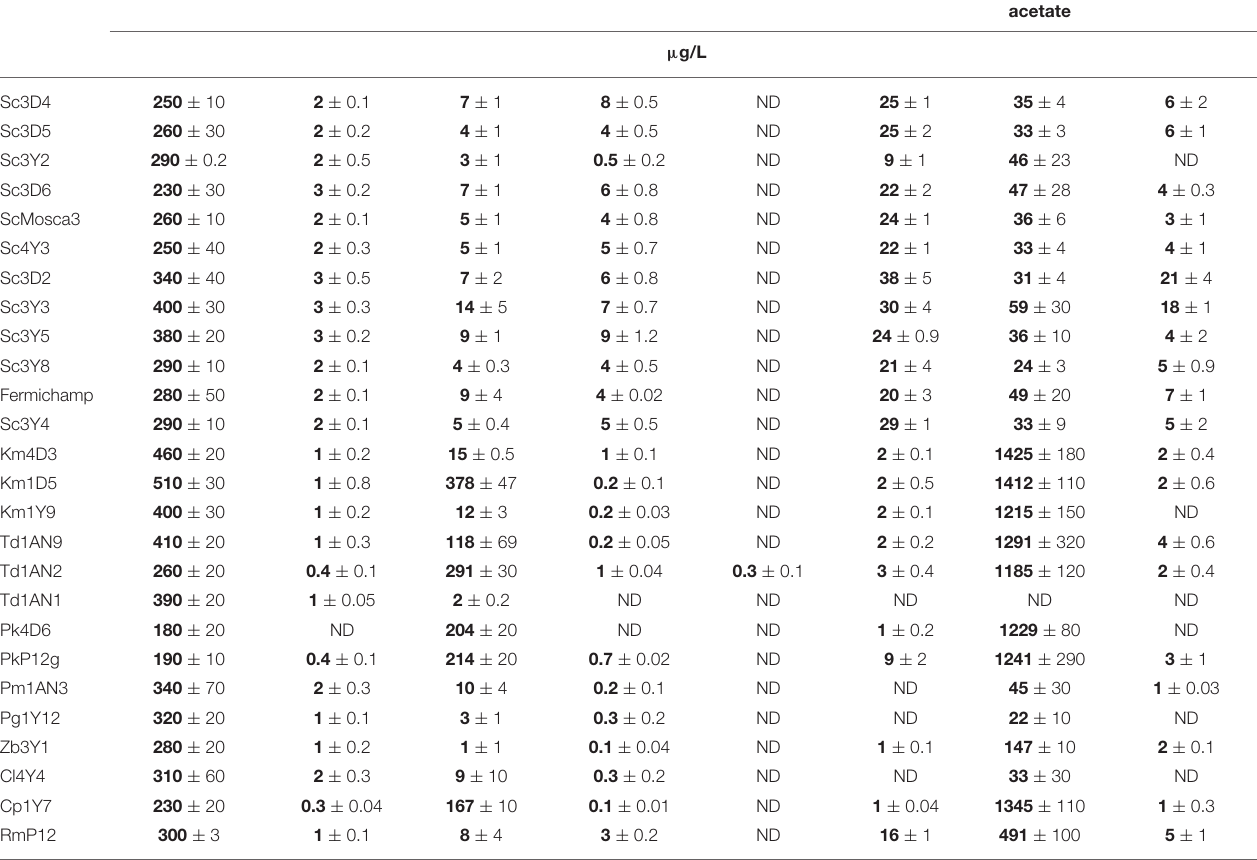
TABLE 2 | Volatile metabolite production for all yeast strains tested at 48h of fermentation in semi synthetic medium M2.